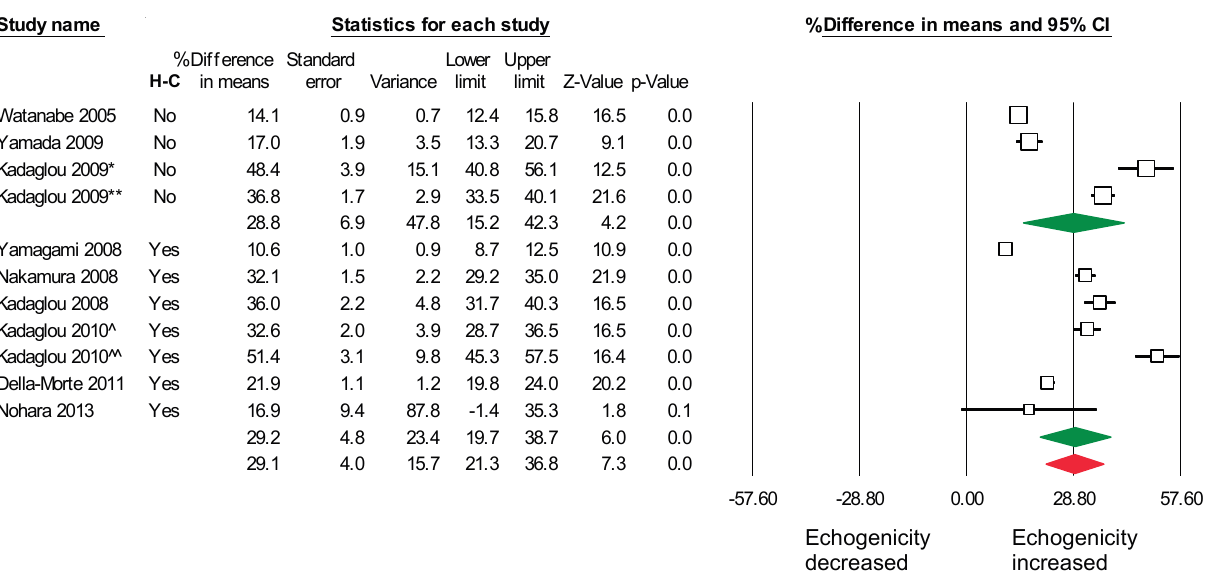
Figure 4. Analysis of studies based on treatment period in months. The effect of statins on plaque echogenicity was obvious from the first month after treatment, and the effect was progressive on the following six and 12 months (m). ( * ) was on statin, but underwent contralateral carotid artery stenting (CAS), and ( ** ) was treated only with statins. (^) received atorvastatin 10–20 mg, and (^^) atorvastatin 80 mg.